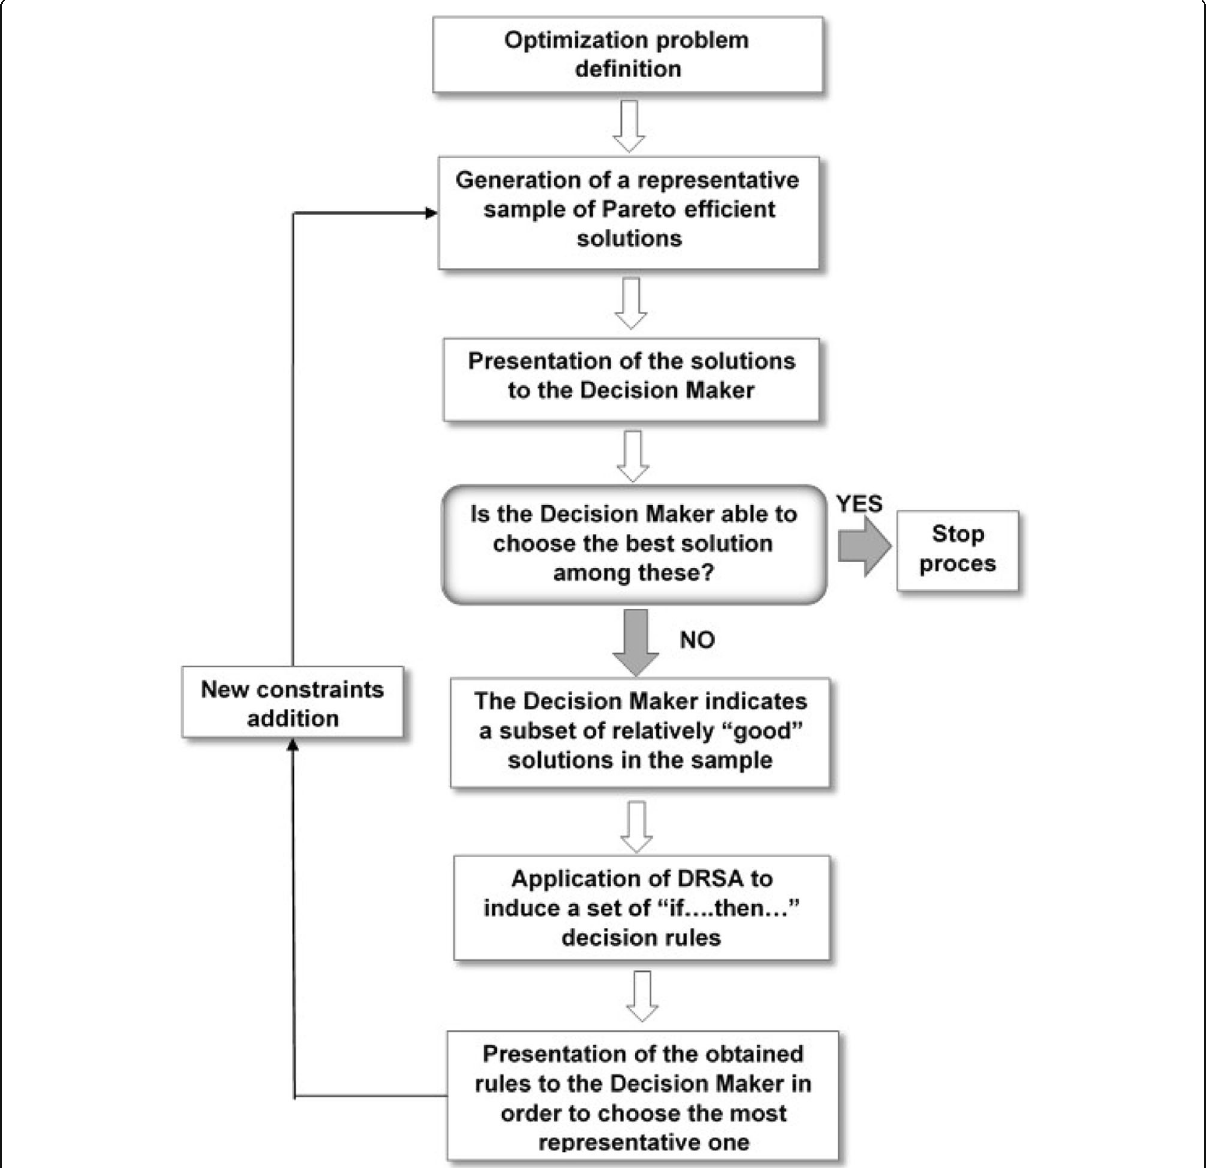
Fig. 1 Framework of the IMO-DRSA